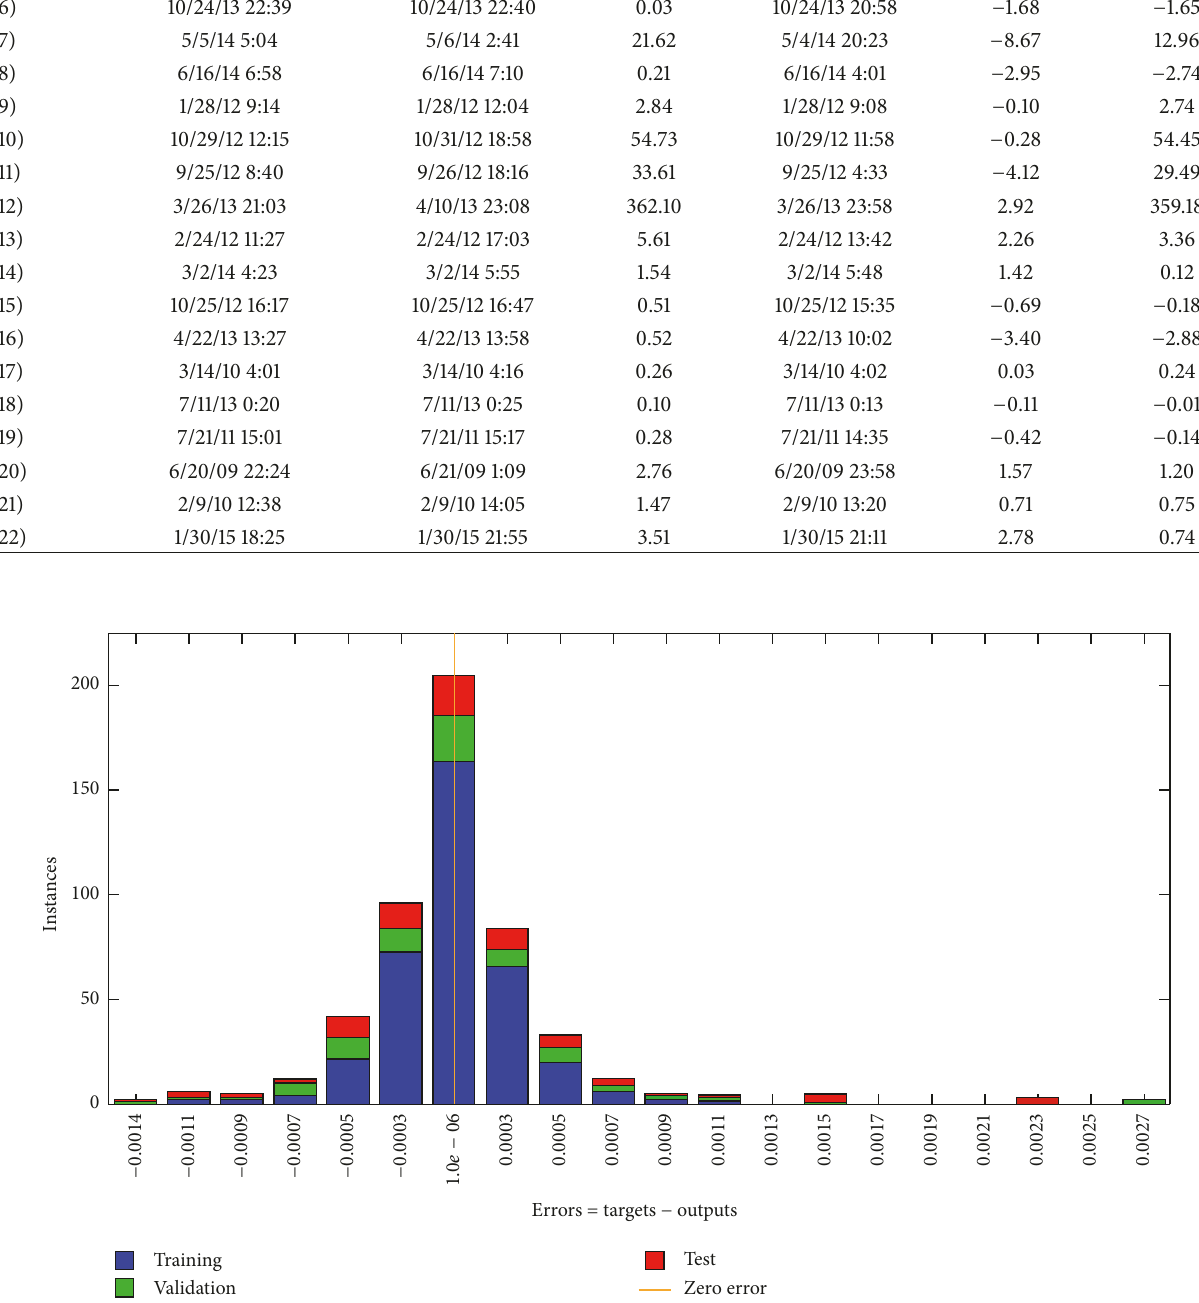
Figure 4: Error histogram from a training